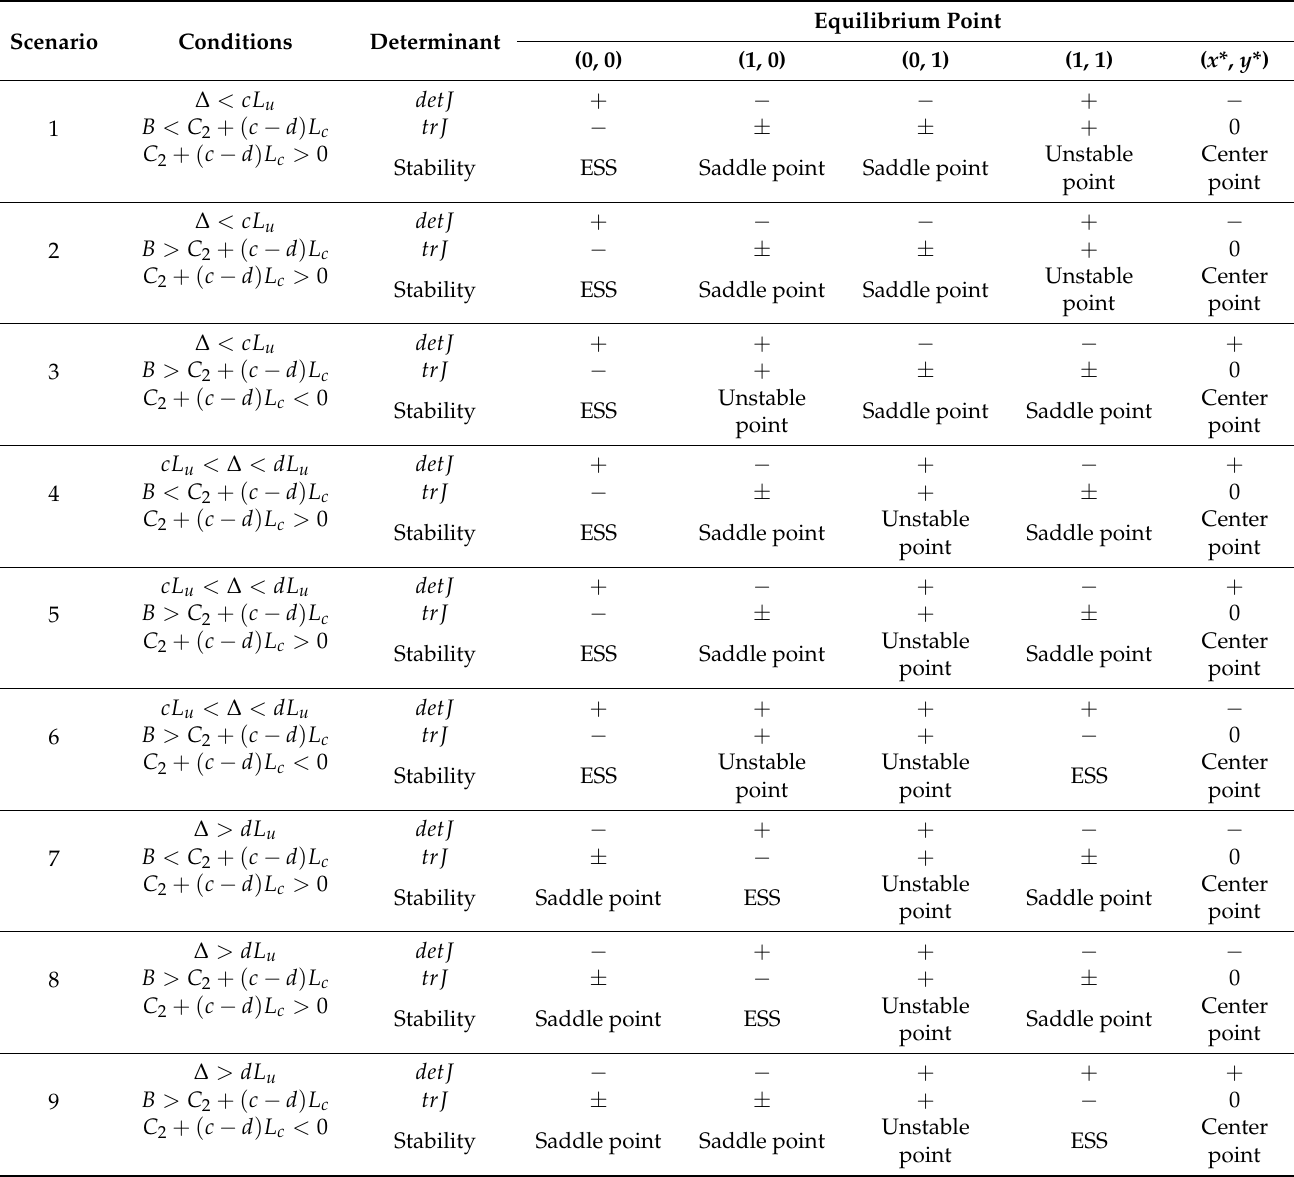
Table 4. Determination of potential equilibrium points in different